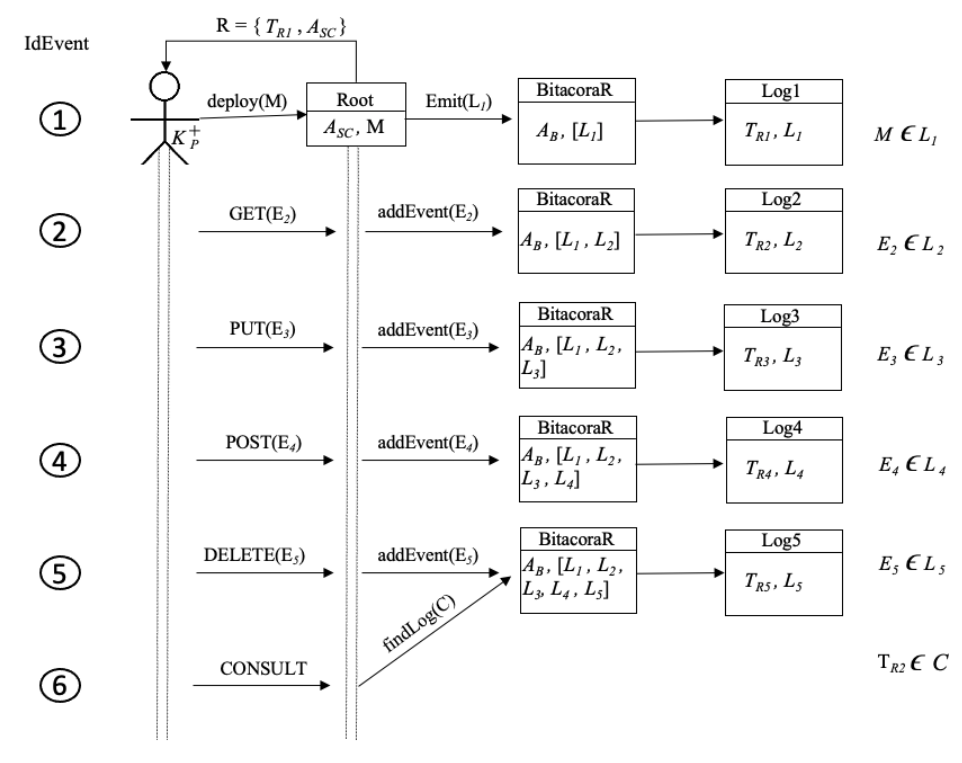
Figure 6. Events’ tree.